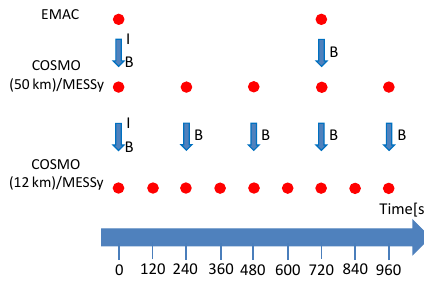
Figure 2. Illustration of the MECO(2) data exchange used in this study. The red circles indicate the time steps, the blue arrows indi- cate the data exchange. The exchange of initial data is marked with I, the exchange of boundary data with